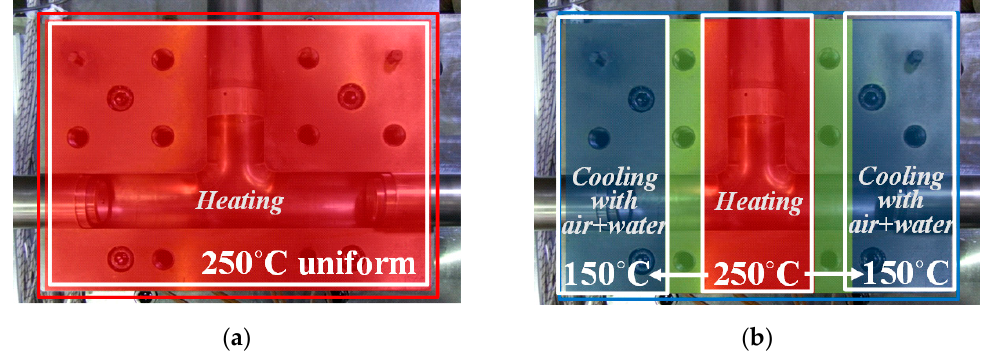
Figure 9. Temperature distribution conditions in warm T-shape forming process for AZ31B. ( a ) Uniform temperature field at 250 °C; ( b ) Non-uniform temperature field.